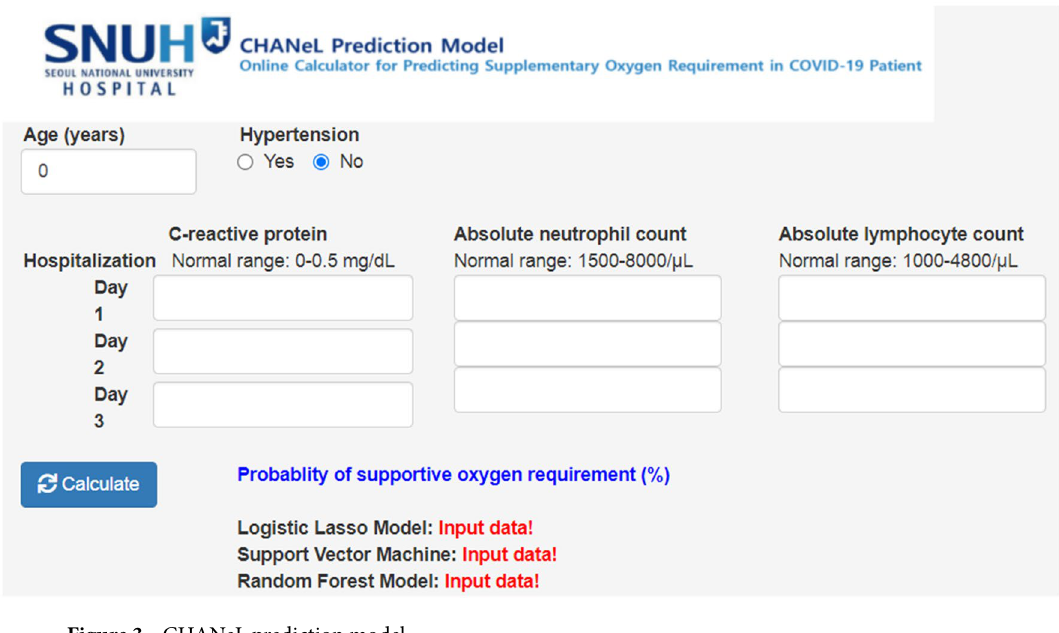
Figure 3. CHANeL prediction